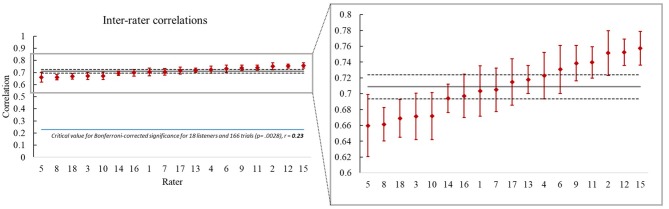
Mean inter-rater correlations (MICs) ordered from lowest (r = 0.66) to highest (r = 0.76) for each of the 18 raters represented by red diamonds. On the left, the entire correlational scale is represented, and on the right a blowup is offered for the region where the scores occurred. On both the left and right, the solid horizontal gray line represents the mean (0.71) across the 18 MICs and the dotted gray lines correspond to the 95% confidence interval (0.694–0.724) for that mean. On the left we also show, with a horizontal blue line, the critical value for statistical significance of the correlations; the huge gap between the critical value correlation and the actual correlations makes clear that the ratings of all the listeners were correlated at a highly significant level (p < 0.00001) with those of the other raters. At the same time the blowup on the right makes it possible to easily examine differences among the 18 listeners in their levels of agreement with the other listeners by evaluating the means and 95% CIs (the error bars) for any pair of listeners. For example, Rater 5 agreed significantly less with the others than Rater 15, since their CIs do not overlap at all. To compare any two raters' levels of agreement with that of any of the other raters, observe the error bars of one with respect to the mean of the other; if the CIs for the first rater do not overlap with the mean for the other rater, the two are significantly different at p < 0.05.